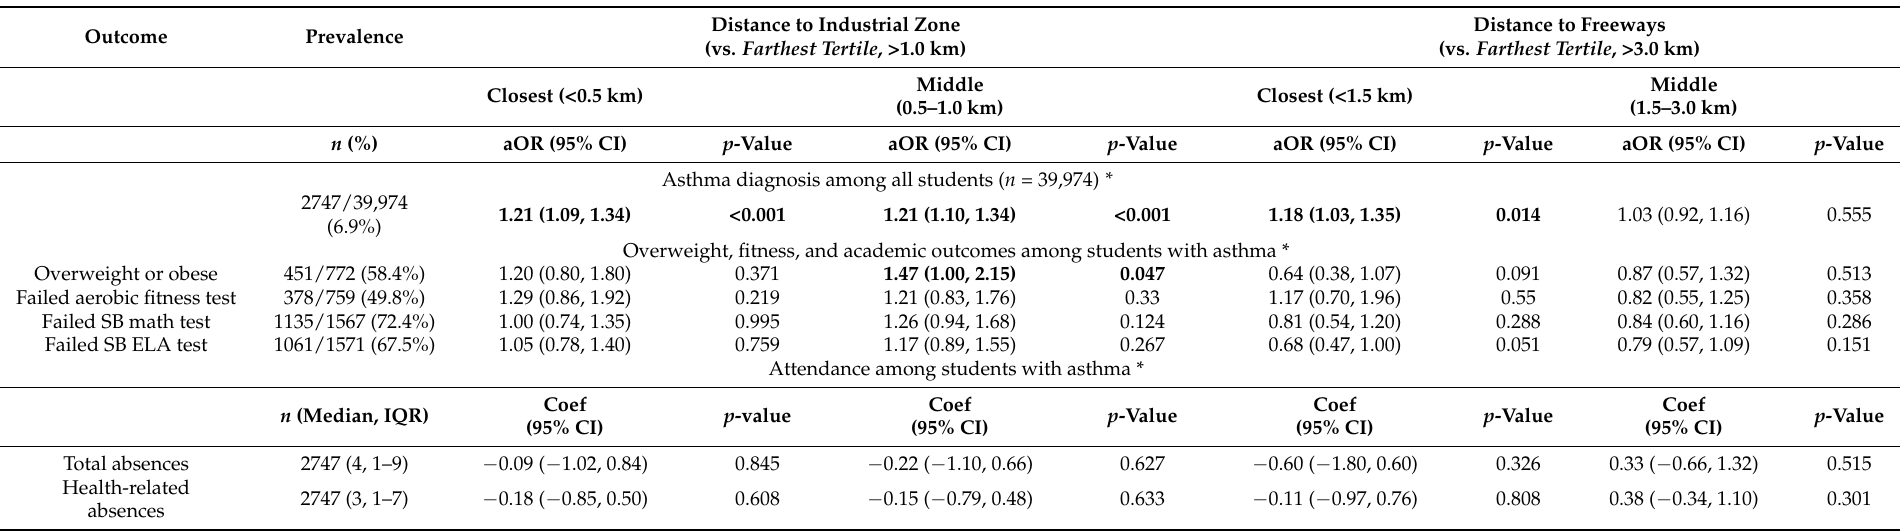
Table 2. Regression models of asthma and academic outcomes by distance to industrial zones and